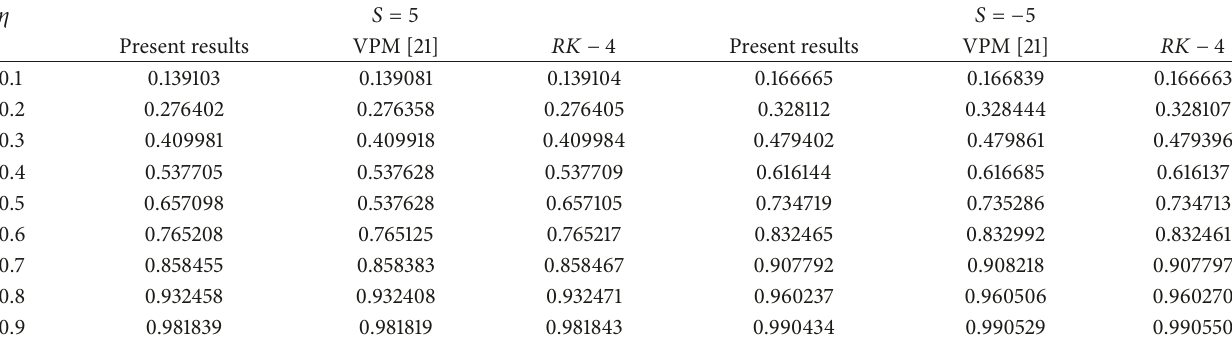
Table 2: Comparison of 𝑓(𝜂) for 𝑀 = 1 and 𝛾 = 0.4 .